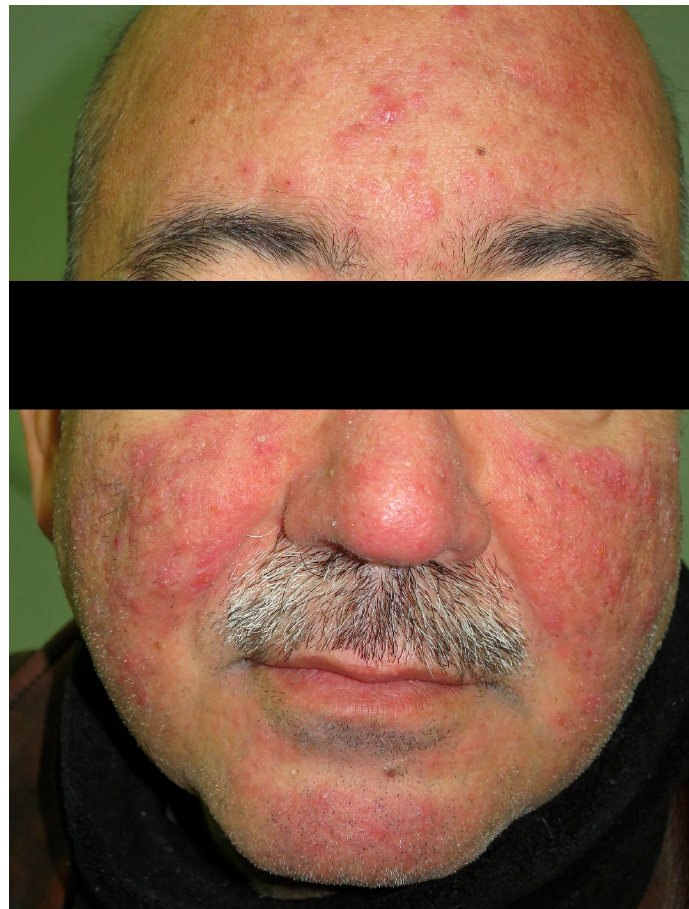
Figure 6. Rosacea. Papule-pustular lesions on the face.